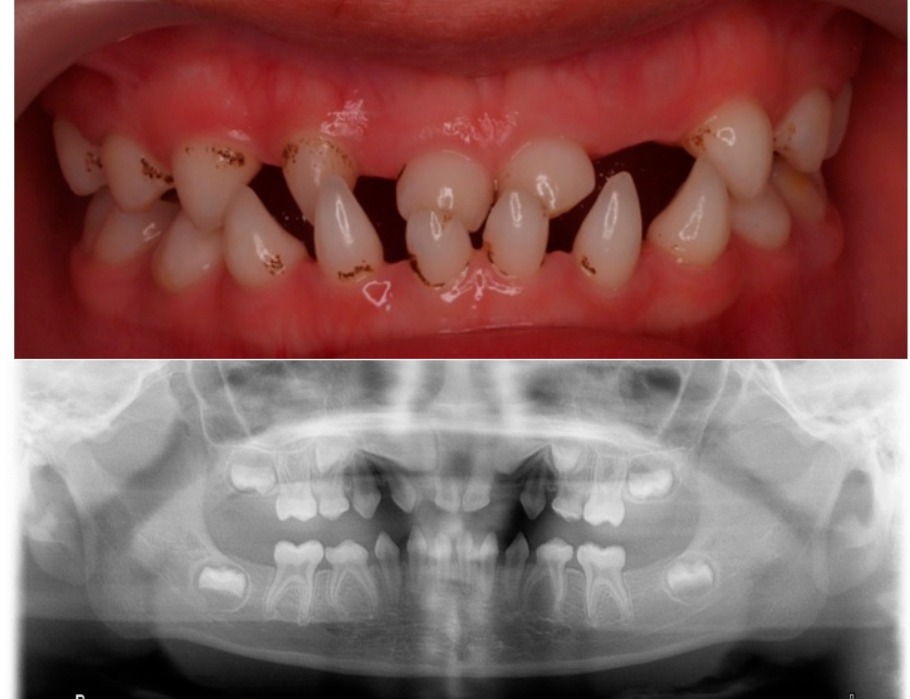
Figure 2. Clinical and radiographical findings at 6 years